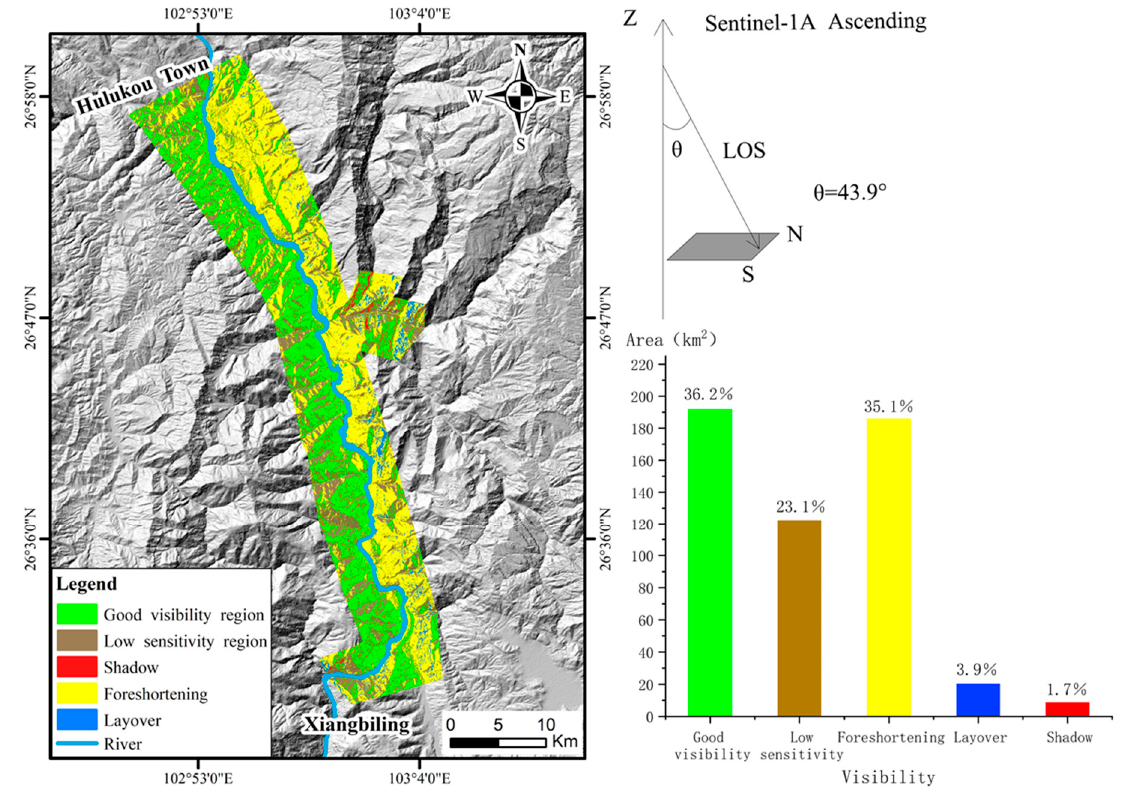
Figure 12. Visibility results of sentinel-1A ascending data in the study area.